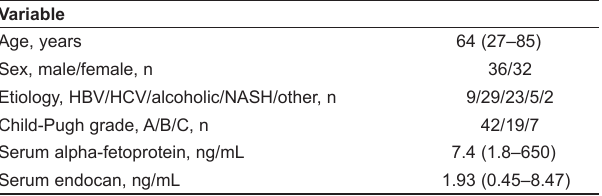
Table 1 baseline characteristics of patients with liver